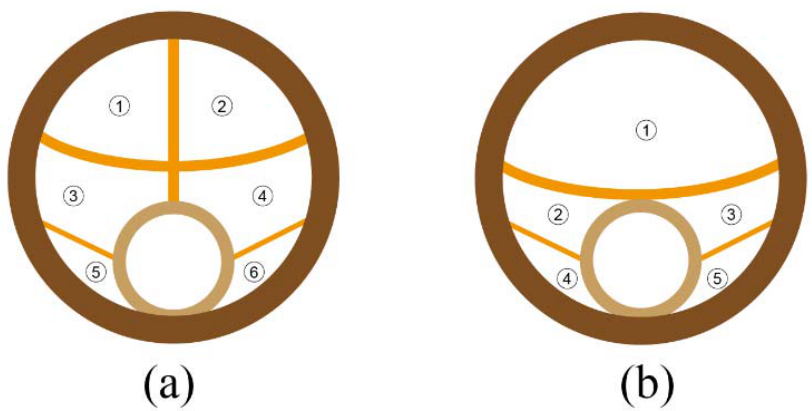
Figure 19. Construction diagram of CRD method and CD method. ( a ) CRD method construction procedure diagram, in which excavation sequence installation ① – ② – ③ – ④ – ⑤ – ⑥ was carried out; ( b ) CD method construction procedure diagram, in which the excavation sequence installation ① – ② – ③ – ④ – ⑤ was carried out.